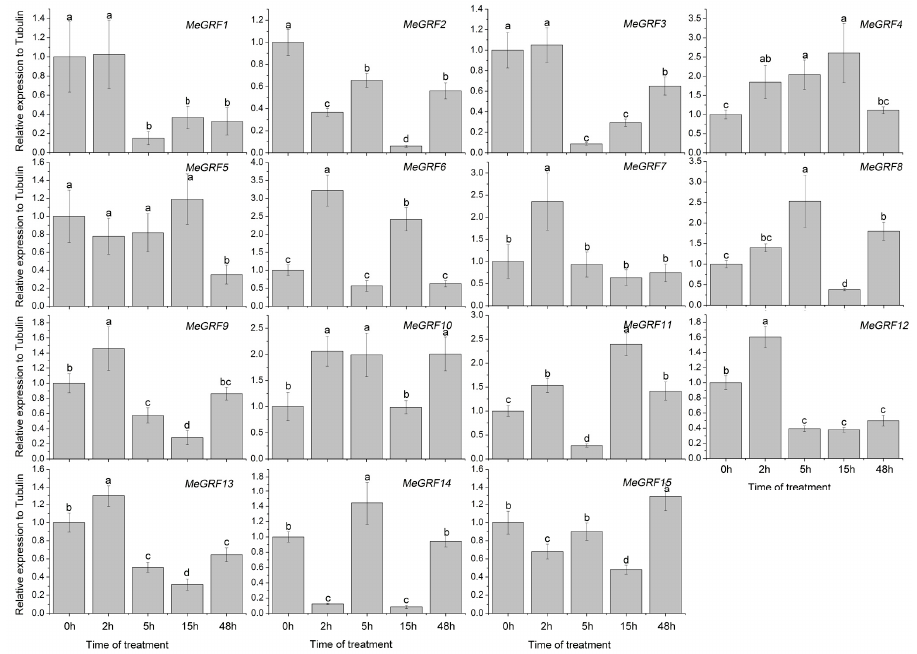
Figure 5. Expression analysis of cassava GRFs in response to cold treatment. The mean fold changes of each gene between treated and control samples at each time point were used to calculate its relative expression levels. No treatment control (NTC) indicates no treatment controls (mean value = 1). Data are means ± standard deviation, SD of n = 3 biological experiments. Means denoted by the same letter do not significantly differ at p < 0.05 as determined by Duncan’s multiple range test.